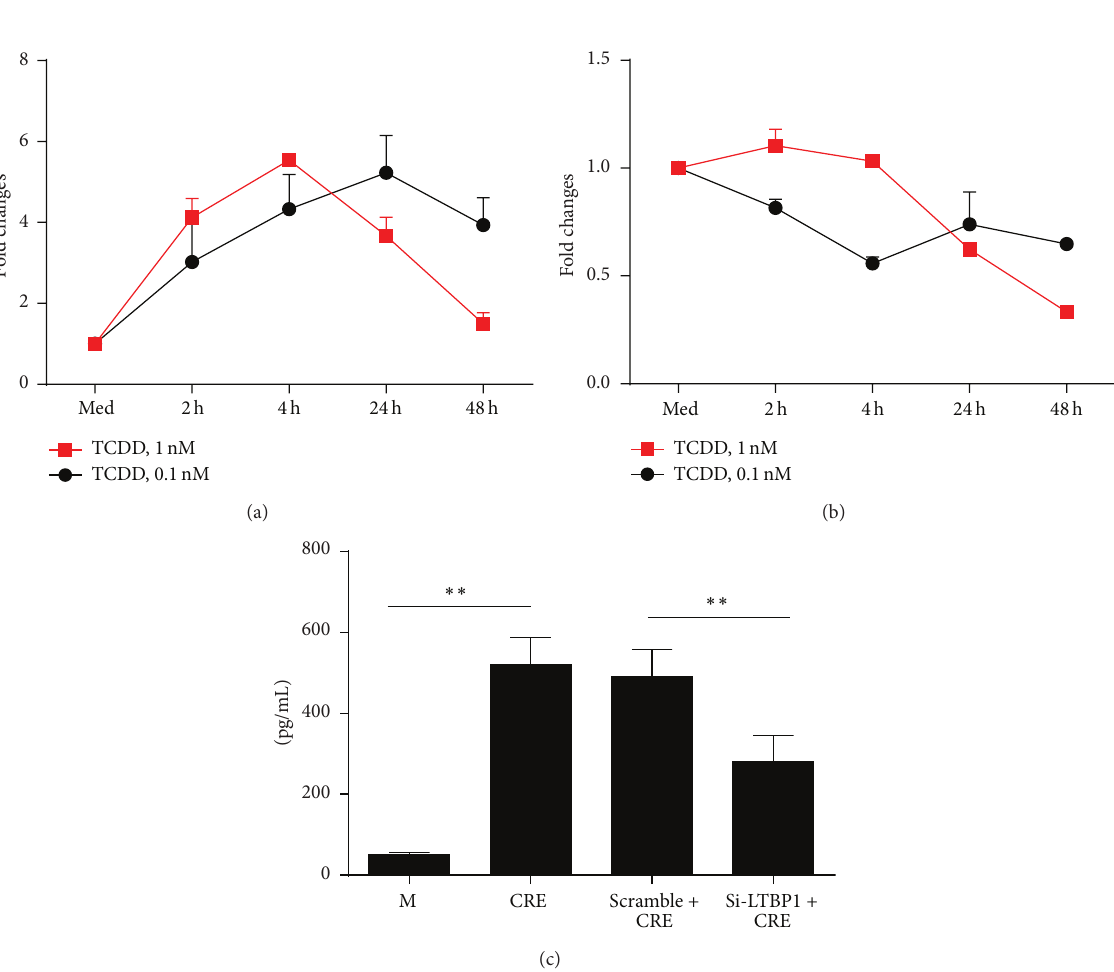
Figure 6: AhR controls LTBP-1 expression in fibroblasts. (a-b) Fibroblasts were treated with TCDD at 0.1 nM and 1nM for 2 to 48 hours; expression of LTBP1 (a) and LTBP-2 (b) was detected by RT-PCR. Each point represents mean ± SEM of at least 3 independent experiments. (c) WI38 cells were treated with LTBP1 siRNA, scramble RNA, or medium control for 24h and then treated with 50 𝜇 g/mL CRE for 24 h; active form TGF 𝛽 1 in the supernatant was detect with